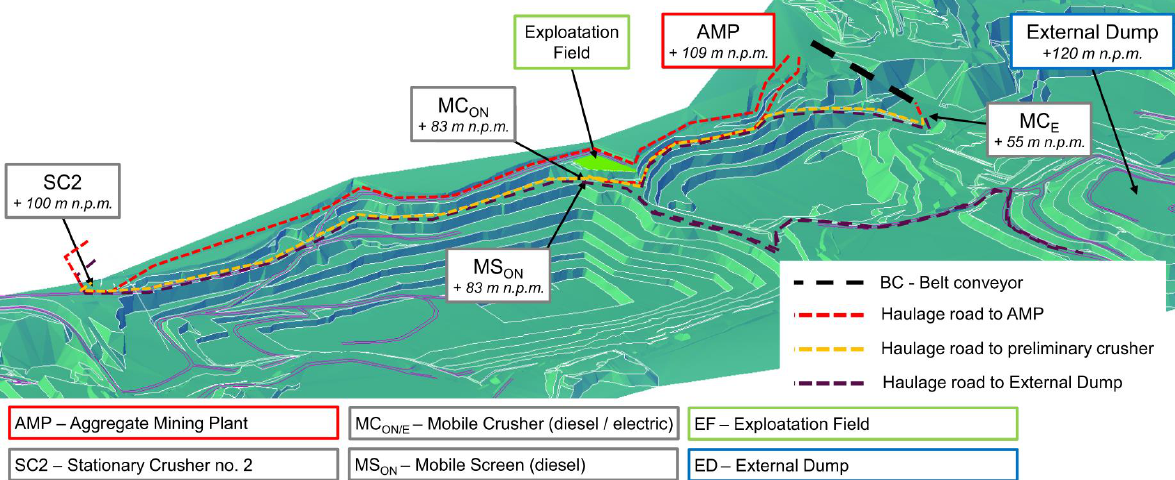
Figure 1. Configuration of the decision variants and the operating conditions of the analysed mine.